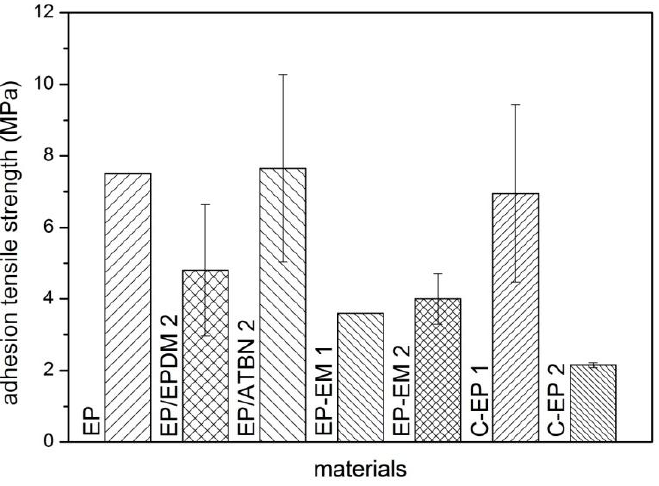
Figure 4. Adhesion tensile strength of the materials, initial